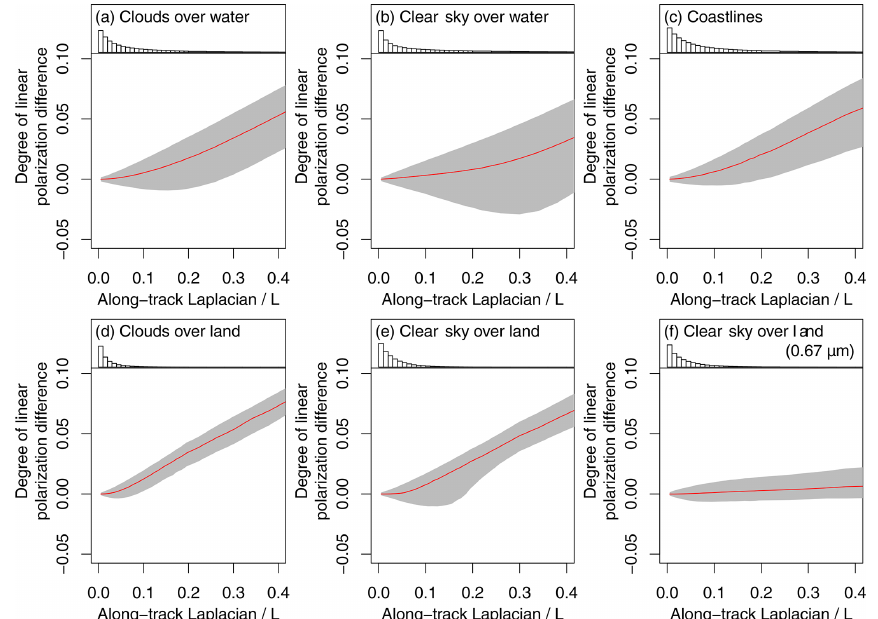
Figure 6. The proxy–reference differences in degree of linear polarization as a function of the along-track Laplacian divided by normalized radiance. The six panels are for (a) clouds over water, (b) clear sky over water, (c) coastlines, (d) clouds over land, (e) clear sky over land, and (f) clear sky over land at 0.674µm. Red curves represent the median, and gray shading indicates the interquartile range. Except for (f) , the wavelength is at